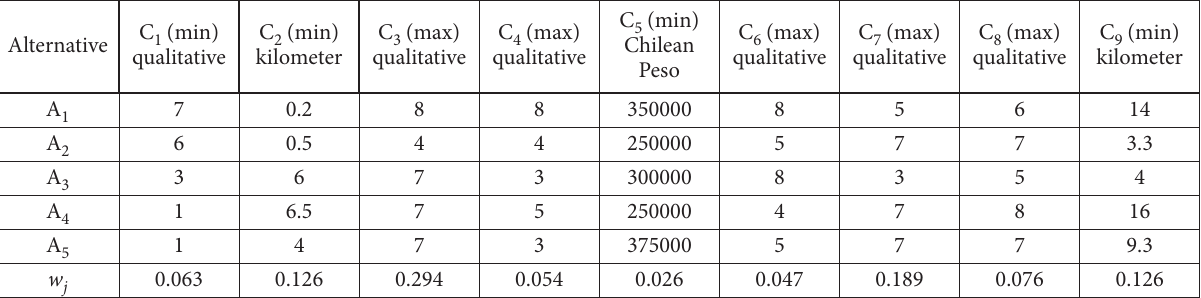
Table 7. The initial decision-making matrix for Scenario 1